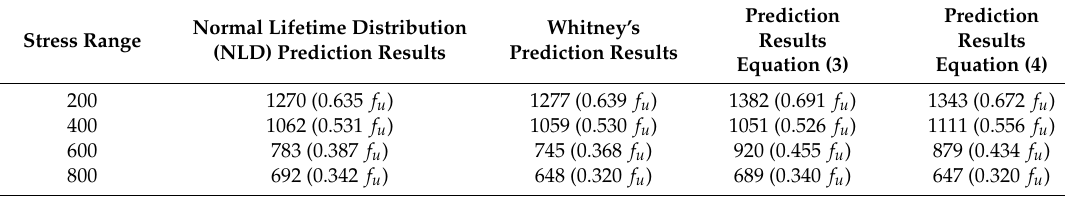
Table 3. Comparison of prediction results (units: